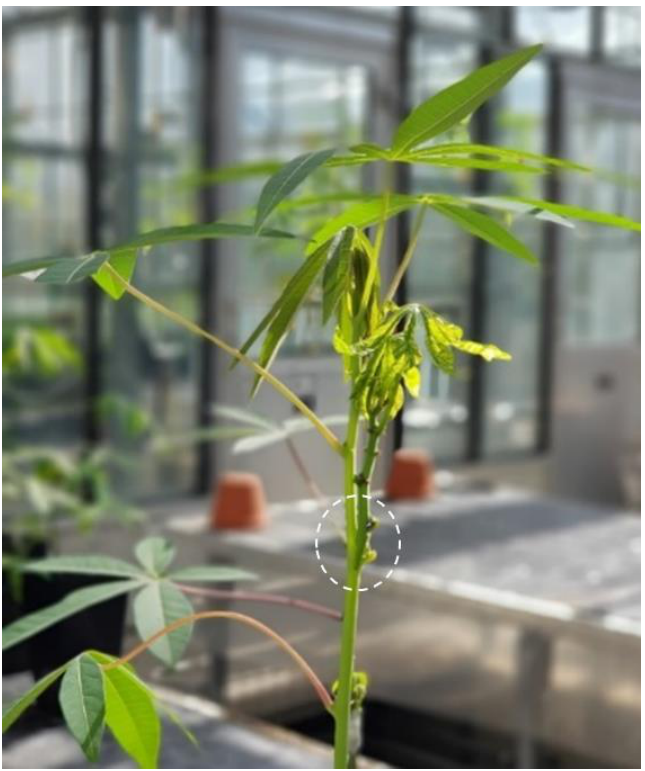
Figure 2. Introducing EACMV infections by side-grafting of scions (open circle) from EACMV- UG/UCBSV mixed-infected